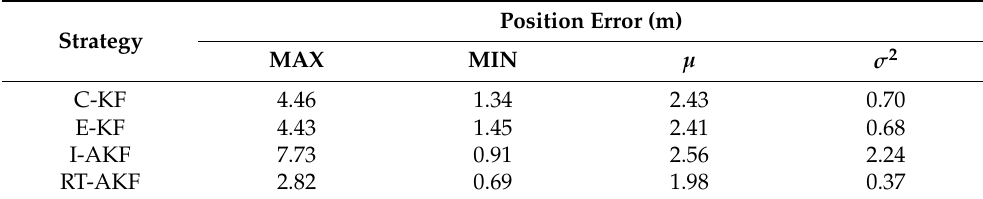
Table 9. Position Error Comparison Using Different Algorithm in Segment